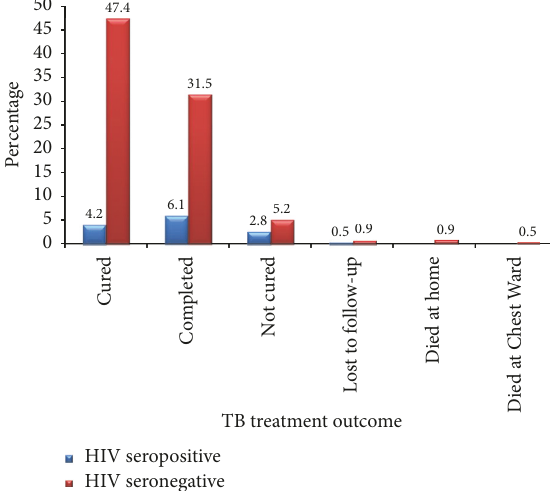
Figure 2: Treatment outcomes for TB/HIV coinfected clients.